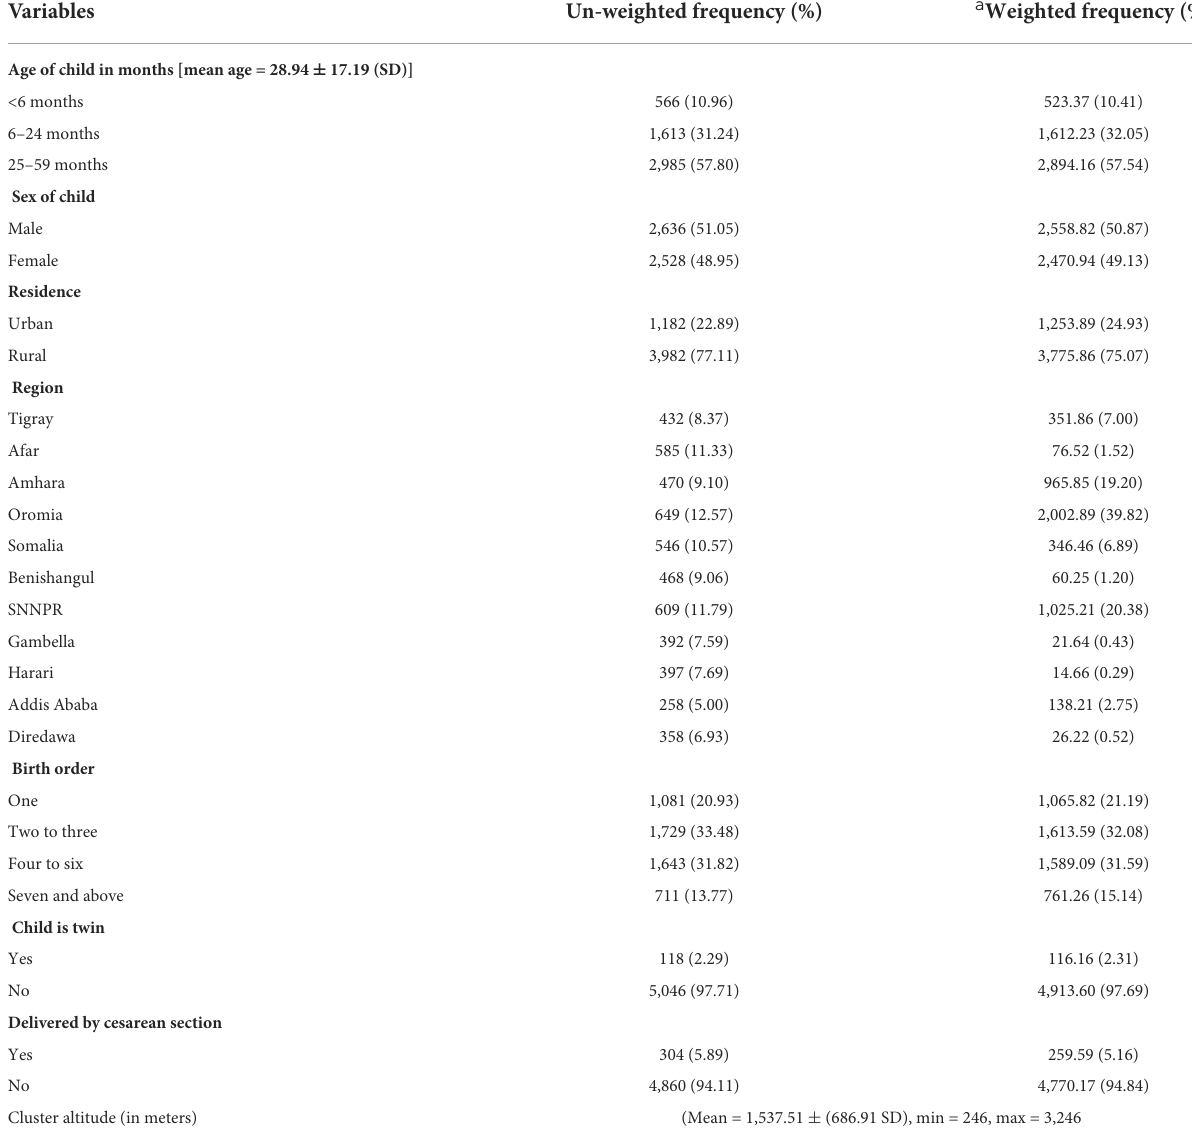
TABLE 2 Socio-demographic characteristics of under-five children in Ethiopia, Ethiopia Mini Demographic and Health Survey (EMDHS)